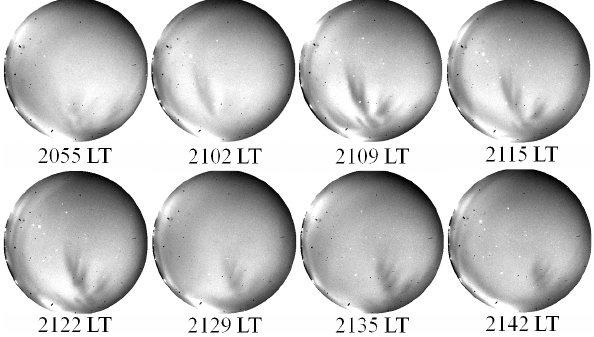
Fig. 4. Sequence of depletions taken in the night of 22 February 2001, from Mt. Alishan, showing the structuring of the eastern wall. The orientation of the images is same as that in Fig.